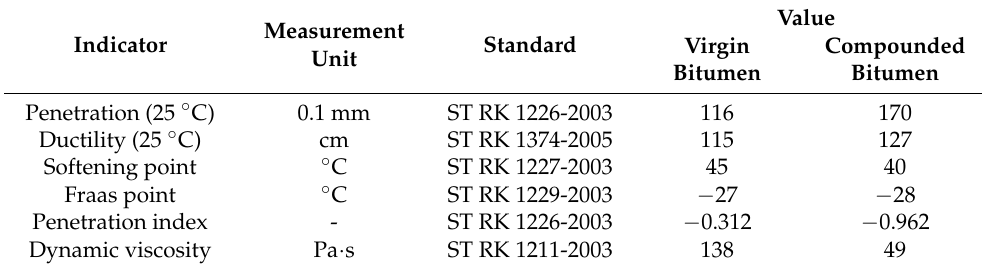
Table 6. Main standard indicators of the virgin and compounded (20% of the tar)